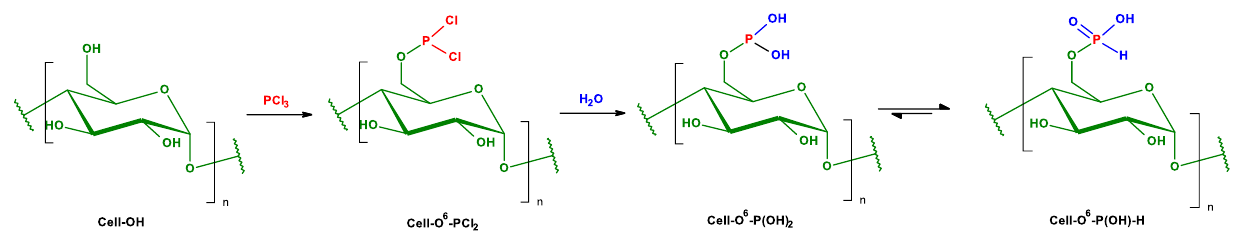
Figure 5. Chemical schemes of vapor phosphorylation of cellulose with PCl 3 .